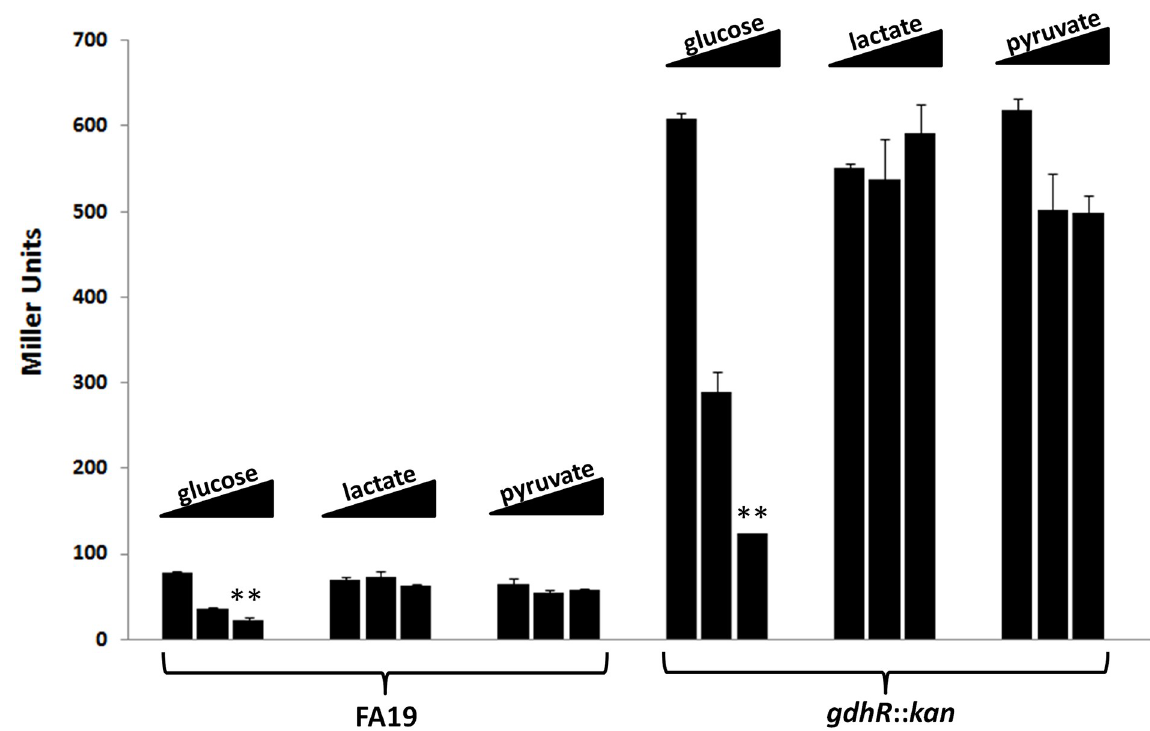
Fig 7. Effect of different carbon sources on lctP expression. FA19 reporter strain JC28 and isogenic mutant JC29 ( gdhR :: kan ) containing an lctP - lacZ fusion in vector pLES94- lctP were grown to stationary phase on GC broth supplemented with a concentration range (1.38, 2.75 and 5.50 mM) for each carbon source. Titration of glucose supplemented cultures was done with a fix concentration of 3 mM L-lactate, and titration with L-lactate or pyruvate was done with a fix concentration of 1.5 mM glucose. β -galactosidase was expressed from the lctP transcriptional and translational signals and its activity was determined in Miller units. Data are presented as the mean (bar) plus the standard error of the mean (error bar) of 3 biological samples and two technical replicates each. �� represents significant statistical differences at p < 0.01 within each carbohydrate titration group as determined by a non-parametric Kruskal-Wallis test and a Dunn’s posttest.